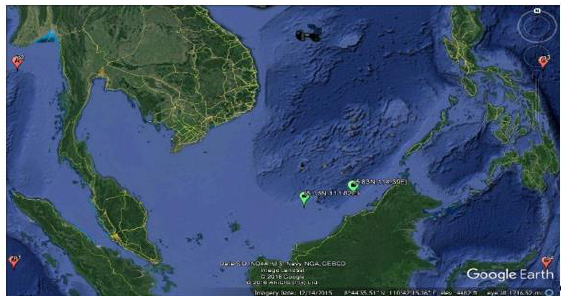
Figure 1. The map of study area (Google Earth,